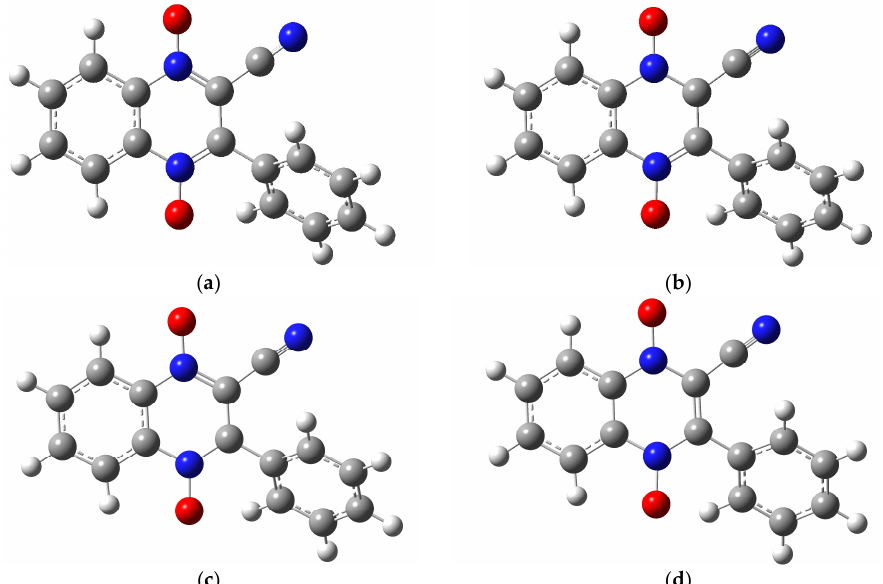
Figure A1. The individual structures for molecule A1 optimized using the 6-31g basis set: ( a ) the neutral molecule; ( b ) the possible anion product from Wave 1 with the radical on C2 ( c ) the possible anion product of Wave 1 with the radical on C3, and ( d ) the dianion product of Wave 2. Chemical structures created in GaussView 5 [30] and optimized in Gaussian 09 [31]. Computation 2017 , 5 , x FOR PEER REVIEW